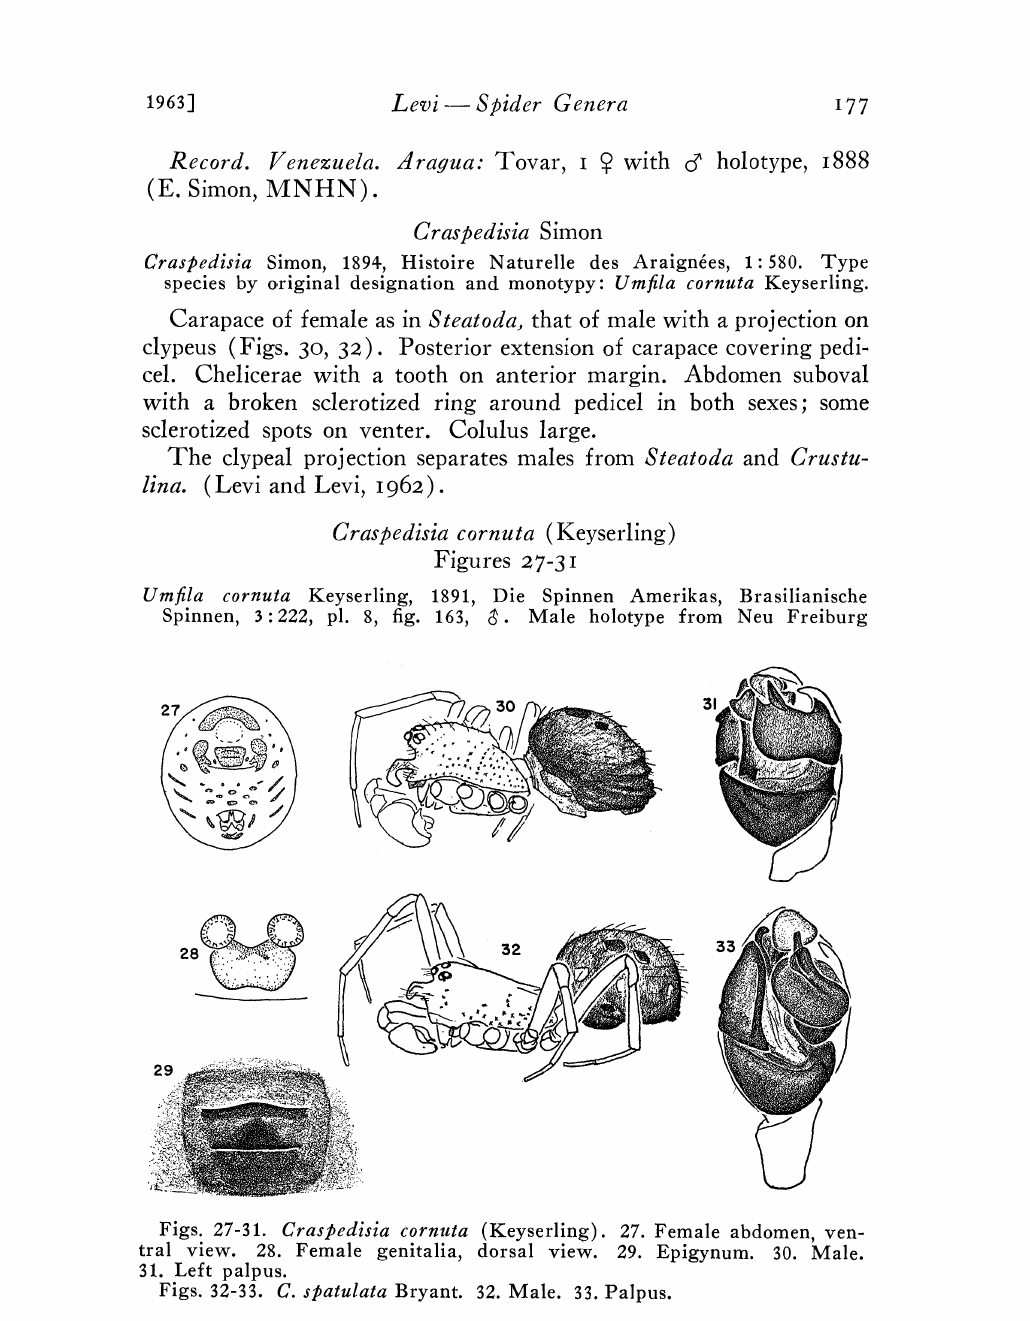
Figs. 27-31. Craspedisia cornuta (Keyserling). 27. Female abdomen, ven- tral view. 28. Female genitalia, dorsal view. 29. Epigynum. 30. Male. 31. Left palpus. Figs. 32-33. C. satulata Bryant. 32. Male. 33.